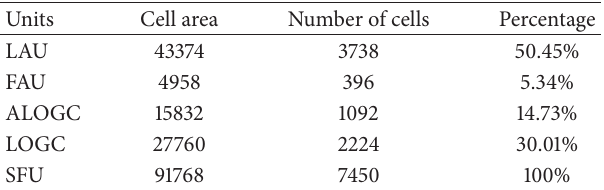
Table 6: Area report of each unit.